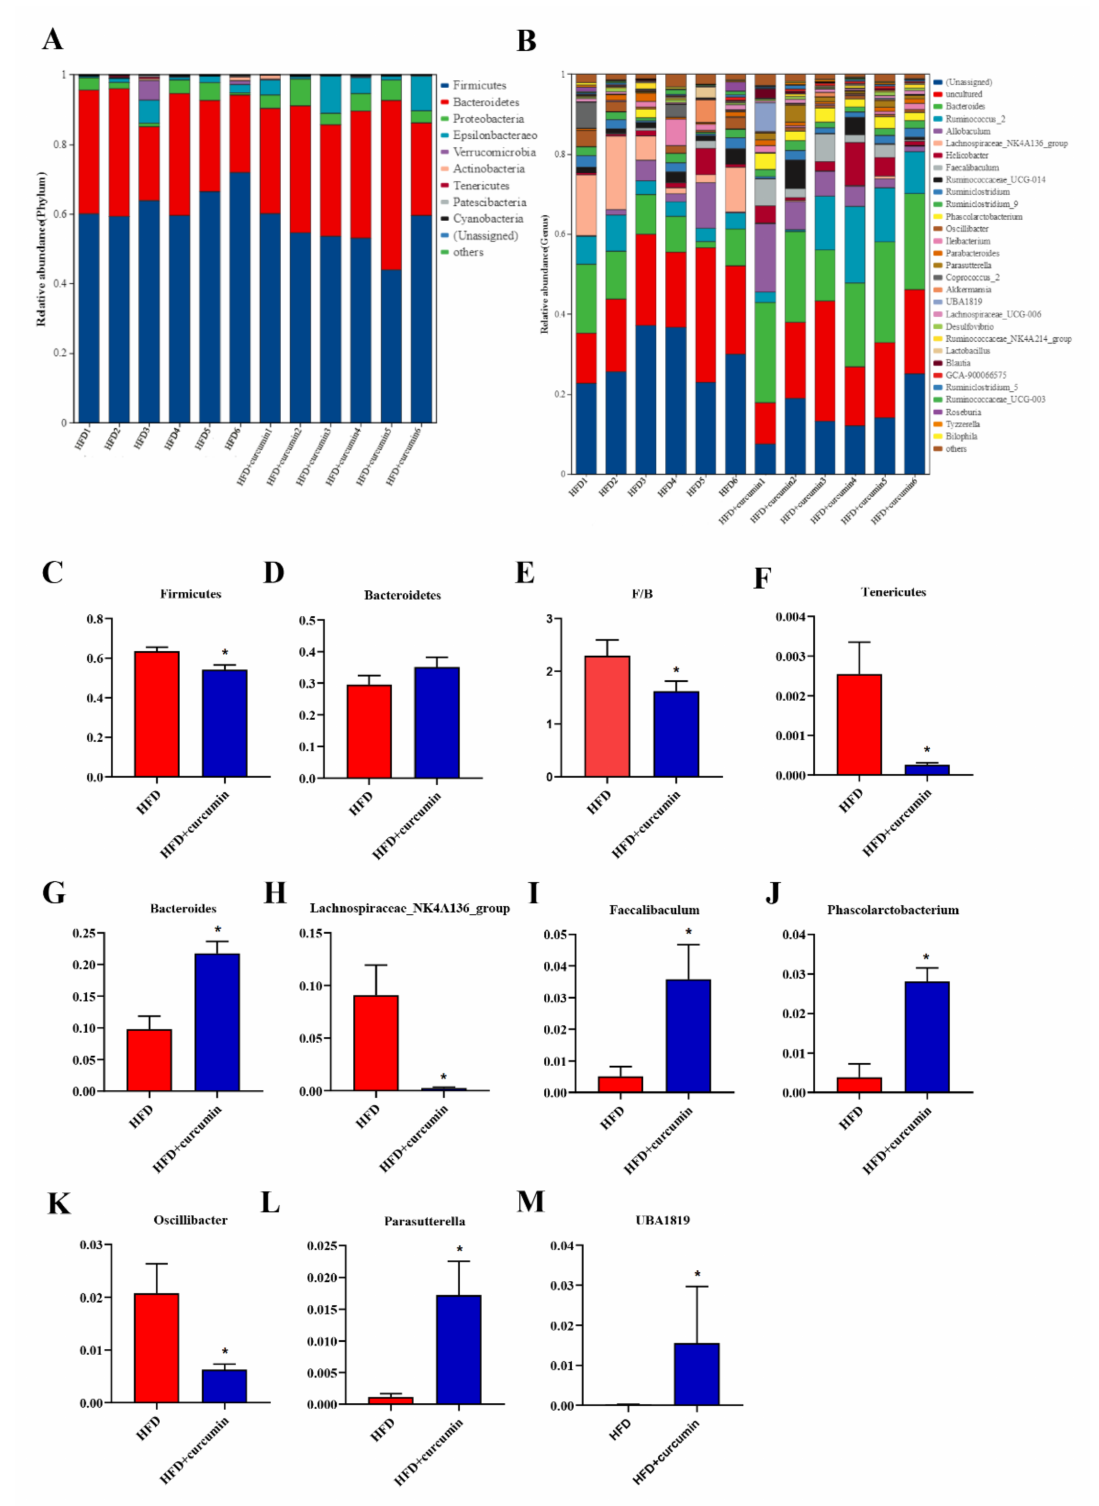
Figure 5. Effects of curcumin on gut microbiota abundance in HFD-fed hamsters. ( A ) Composition of gut microbiota at phylum level; ( B ) Composition of gut microbiota at genus level; ( C , D ) The relative abundance of Firmicutes , Bacteroidetes ; ( E ) The ratio of firmicutes to Bacteroidetes ; ( F ) The relative abun- dance of Tenericutes ; ( G – M ) The relative abundance of Bacteroides , Lachnospiraceae_NK4A136_group , Faecalibaculum , Phascolarctobacterium , Oscillibacter , Parasutterella and UBA1819 . Data are expressed as mean ± SEM ( n = 6), * p < 0.05 compared to HFD